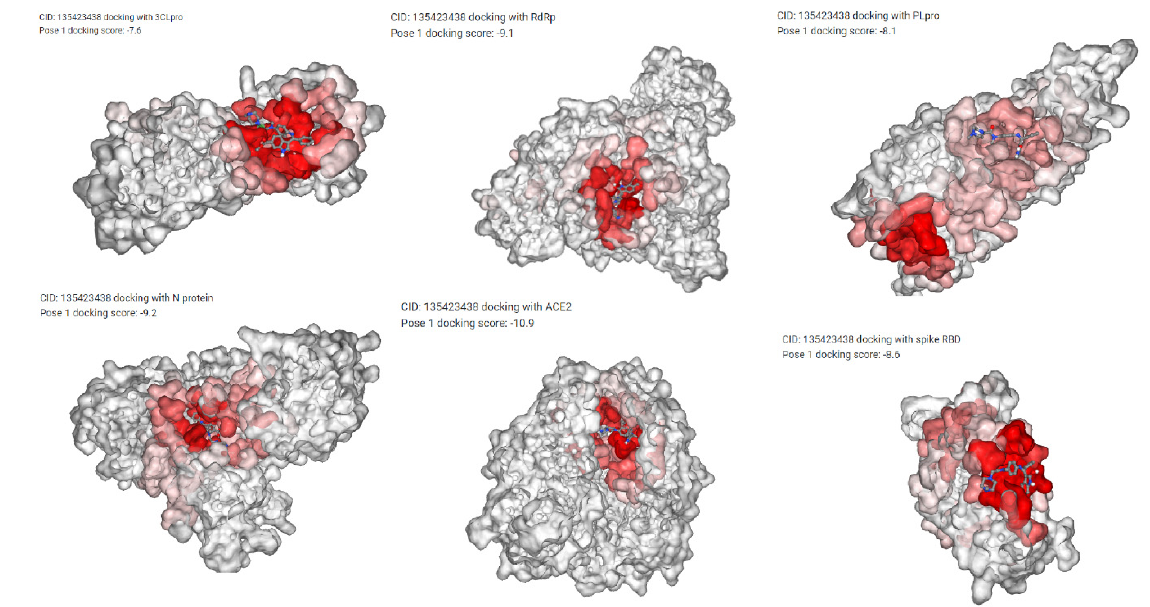
Figure 10. Best poses results of Docking of Nintedanib (CID: 135423438) with spike protein, 3CLpro, PLpro, RdRp, N protein, and ACE2.